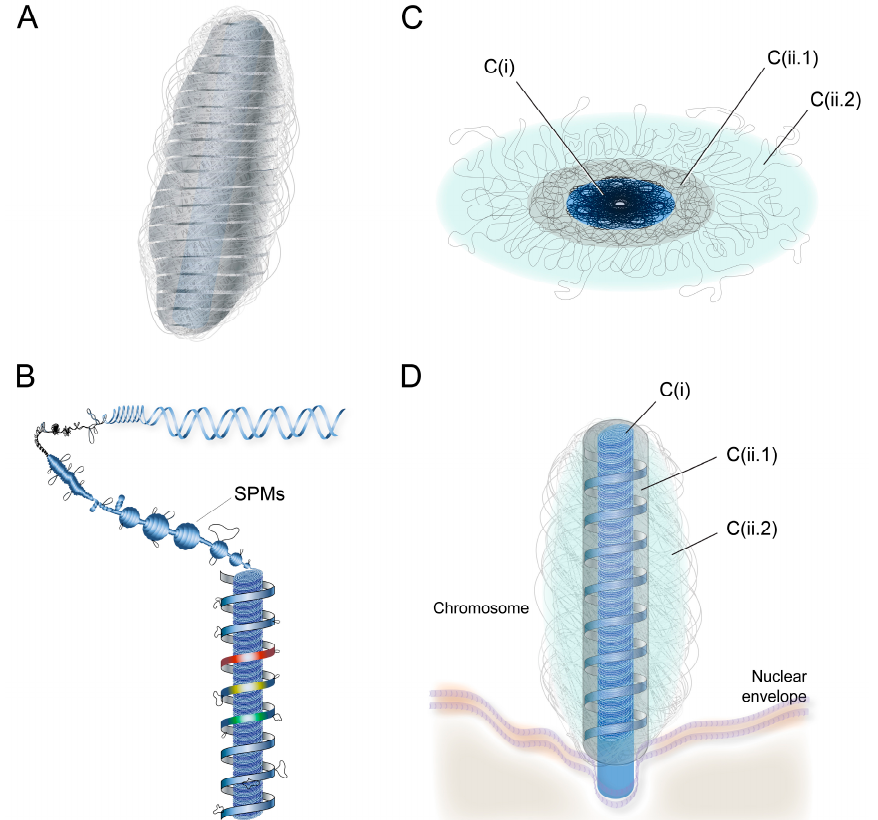
Figure 2. Proposed compartmental superhelical liquid crystalline model for dinoflagellate liquid crystalline chromosomes. Diagrammatic representation of (a) a chromonema composed of spiraling supercoiled plectonemic modules (SPMs); (b) lateral section of a highly condensed/compacted C(i) superimposed under C(ii.1), composed of chromonema coil-spiraling (partially decompacted to show C(i)); (c) the horizontal section of a LCC showing core C(i), the surface C(ii.1) and C(ii.2) consisting of peripheral extrachromosomal loop (PCL); and (d) a LCC on nuclear envelope (NE) during dinomitosis; partially decompacted to show C(ii.1) chromonema spiraling, around C(i). (figure drawn by Alvin Kwok).